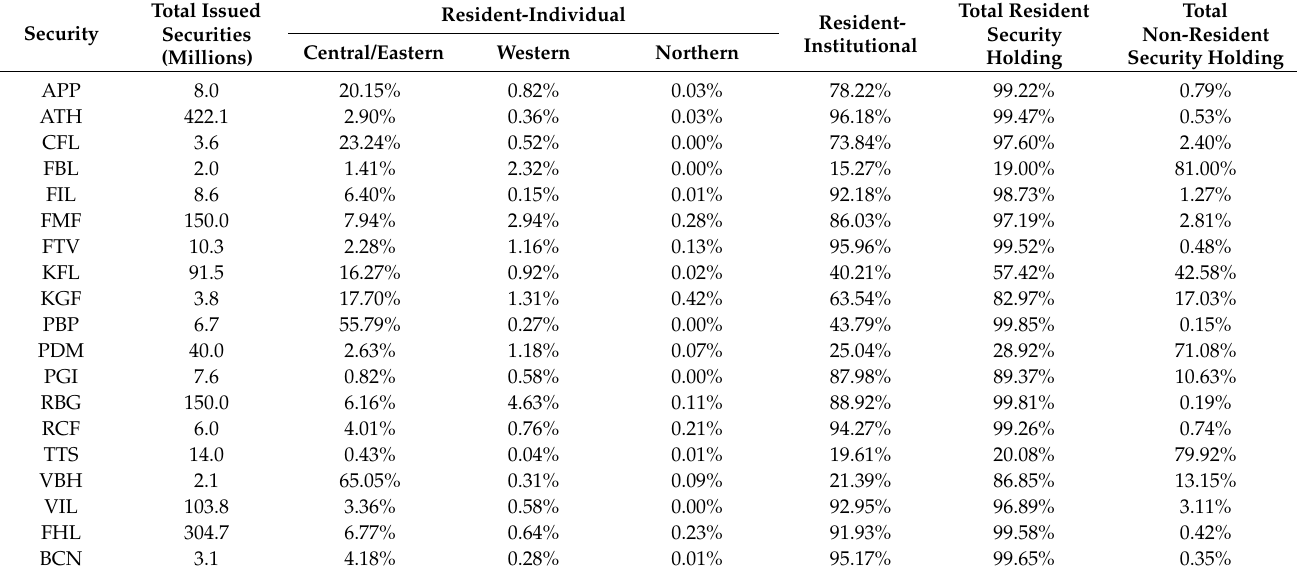
Table 6. Percentage of Resident Retail Security Holding by Location, Resident Institutional, and Non-Resident Security